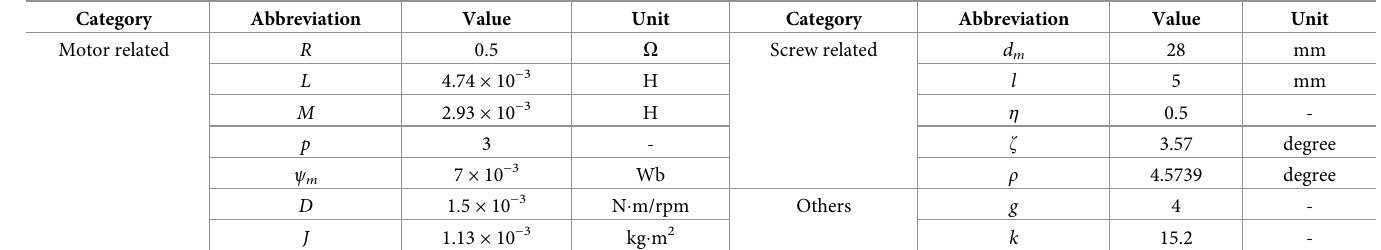
Table 1. Parameters of the EMB system model.